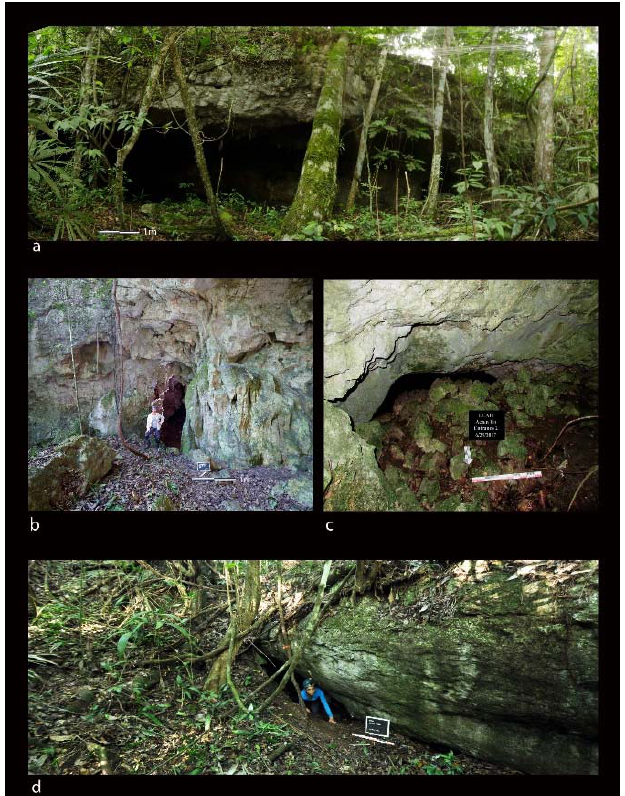
Figure 5. Horizontal cave entrances: ( a ) large entrance, Bird Tower Cave; ( b ) medium-sized entrance, Eduardo Quiroz Cave; ( c ) small entrance, Actun Uo (Uo Frog Cave); and ( d ) fissure entrance, Actun Z’uhuy Ch’en (Untouched Cave). (Photos courtesy of LCAR).